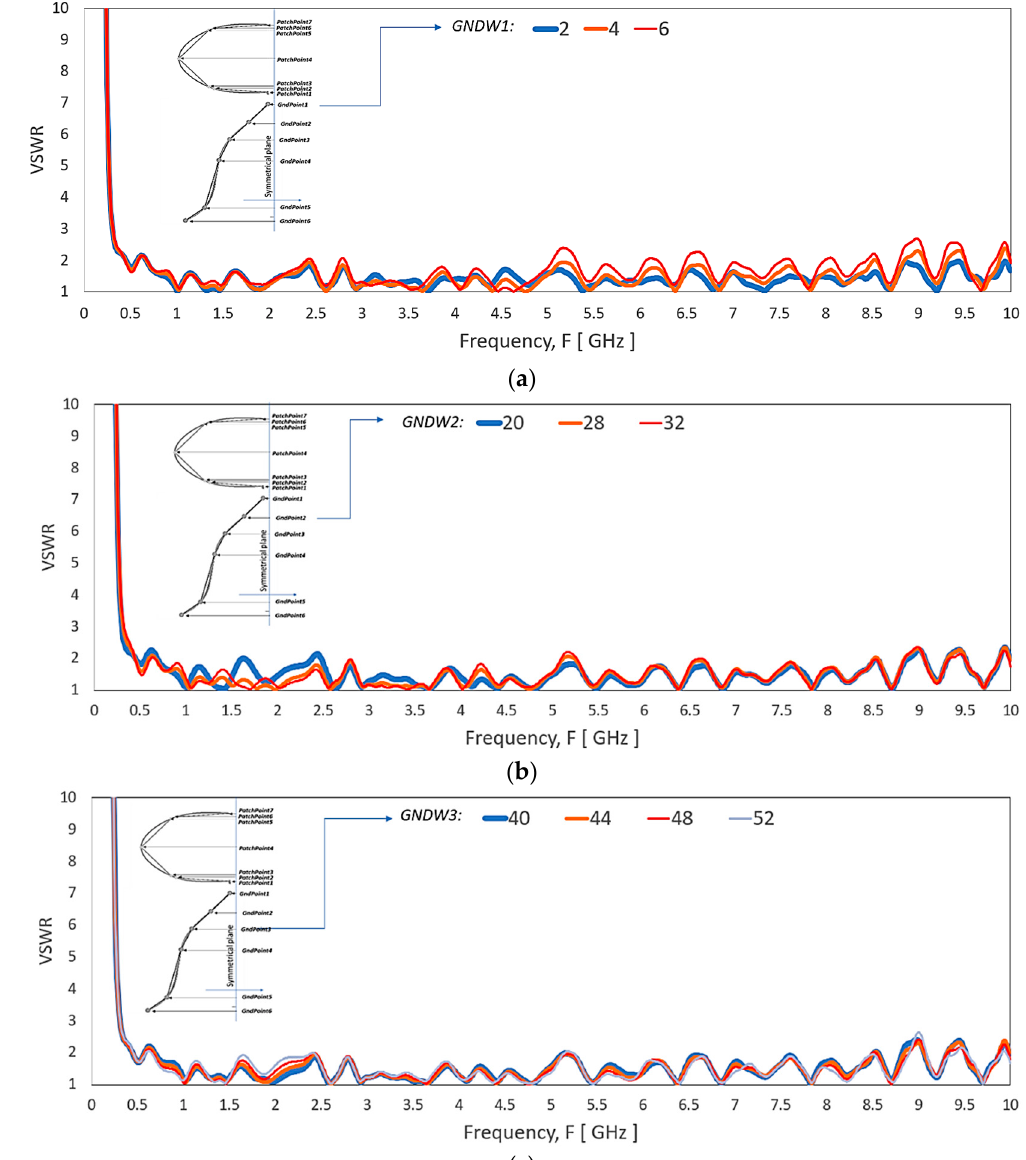
Figure 17. VSWR of the antenna by varying the ( a ) GNDW1 , ( b ) GNDW2 ( c ) GNDW3 of the ground plane.